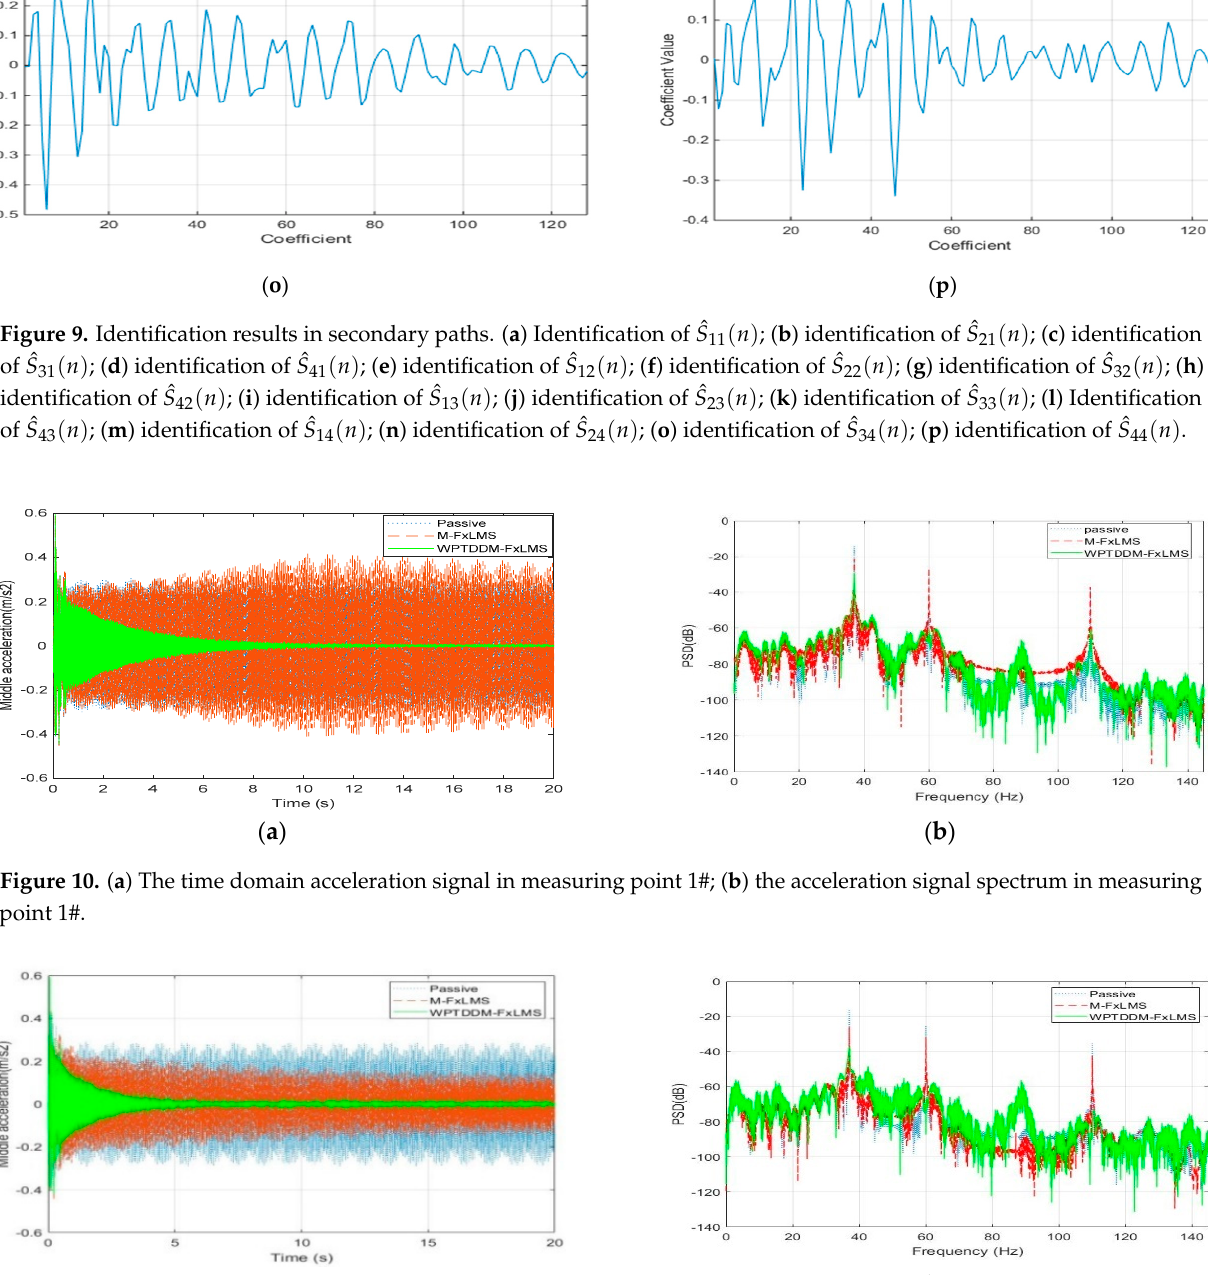
Figure 11. ( a ) The time domain acceleration signal in measuring point 2#; ( b ) The acceleration signal spectrum in measuring point 2#.